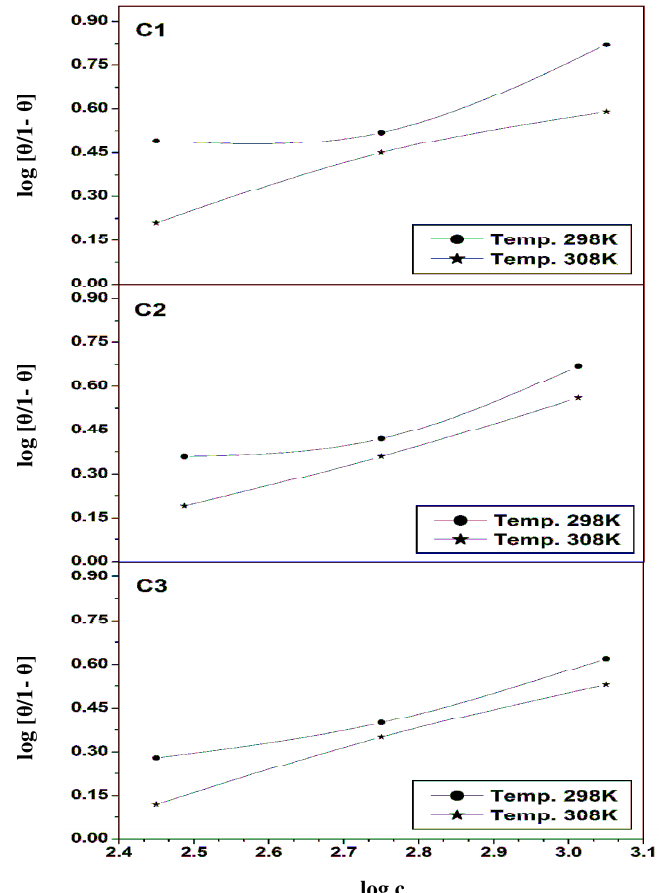
Figure 6. Langmuir adsorption isotherm at different temperatures for different inhibitors in 0.5 N